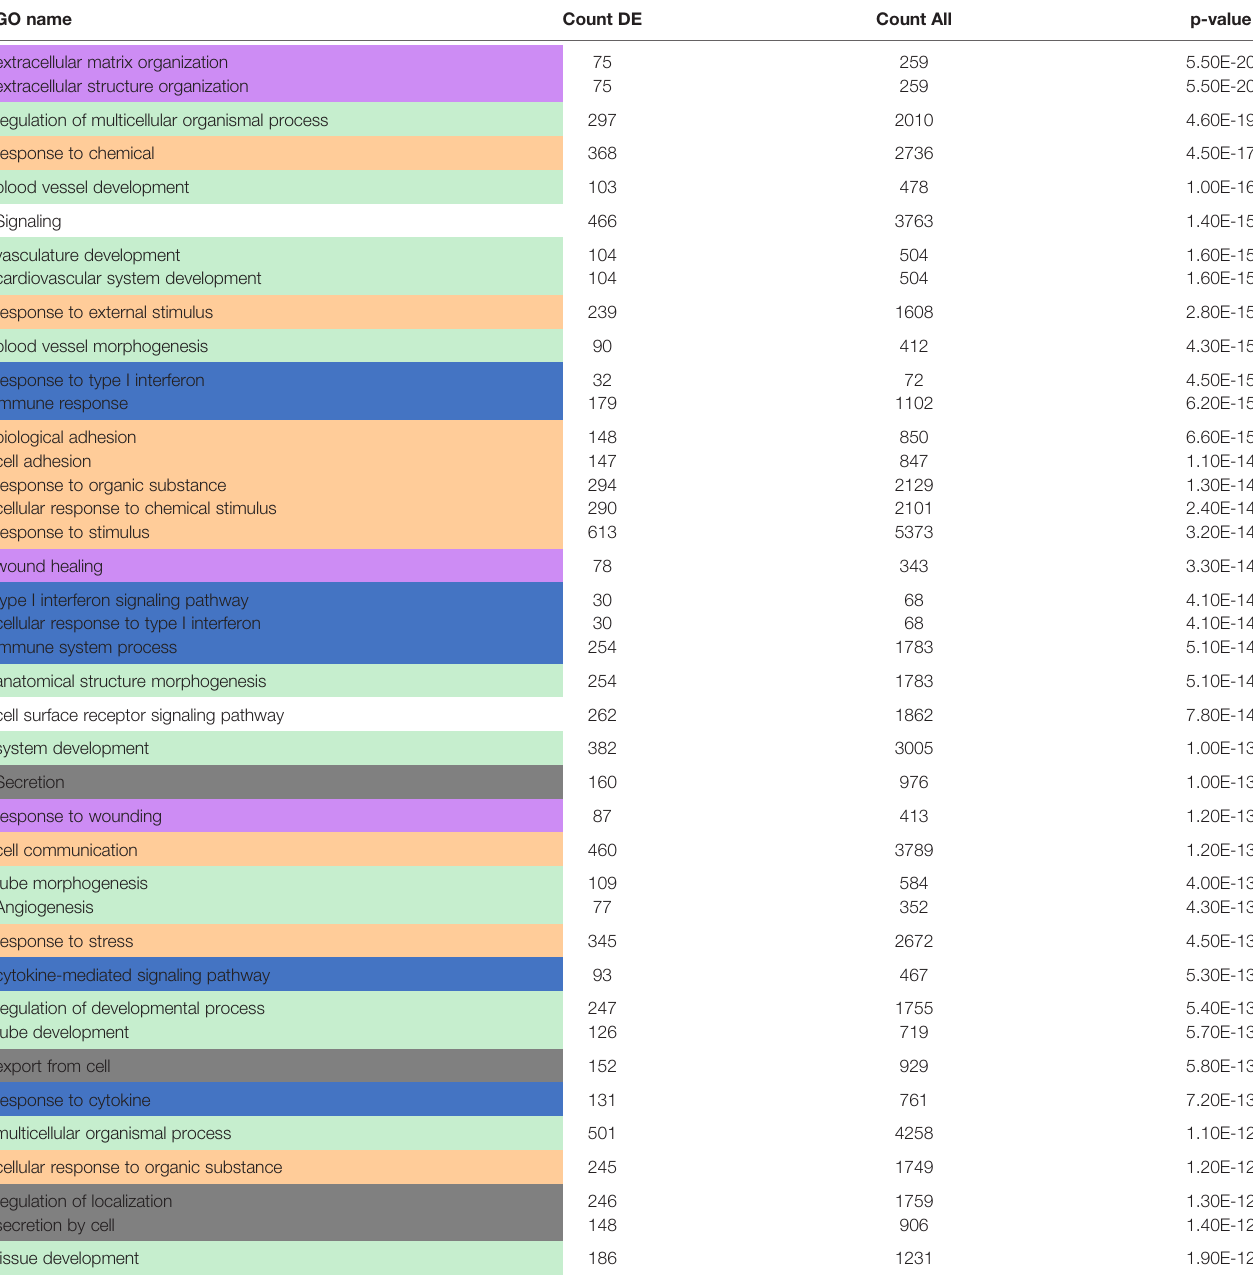
full output table is shown in Supplementary Table 10 . DE, differentially expressed; GO, gene